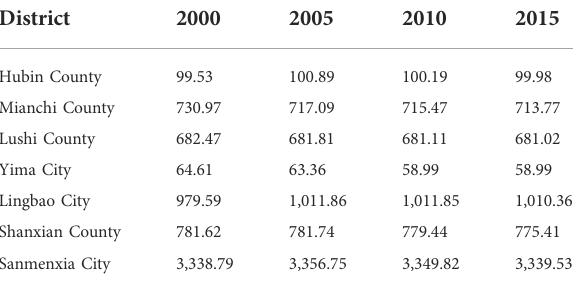
TABLE 1 Farmland area in Sanmenxia City from 2000 to 2015 Unit: hm 2 .